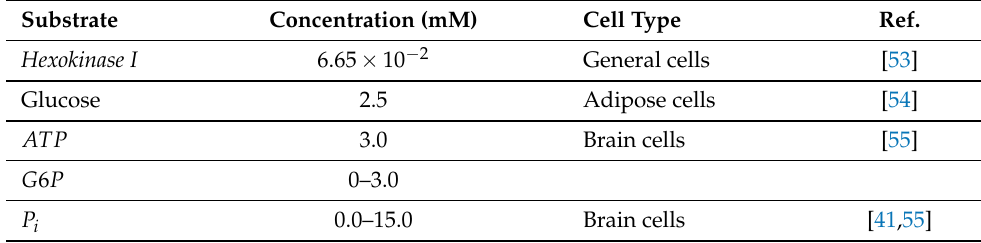
Table 3. Intracellular concentrations of hexokinase I and some